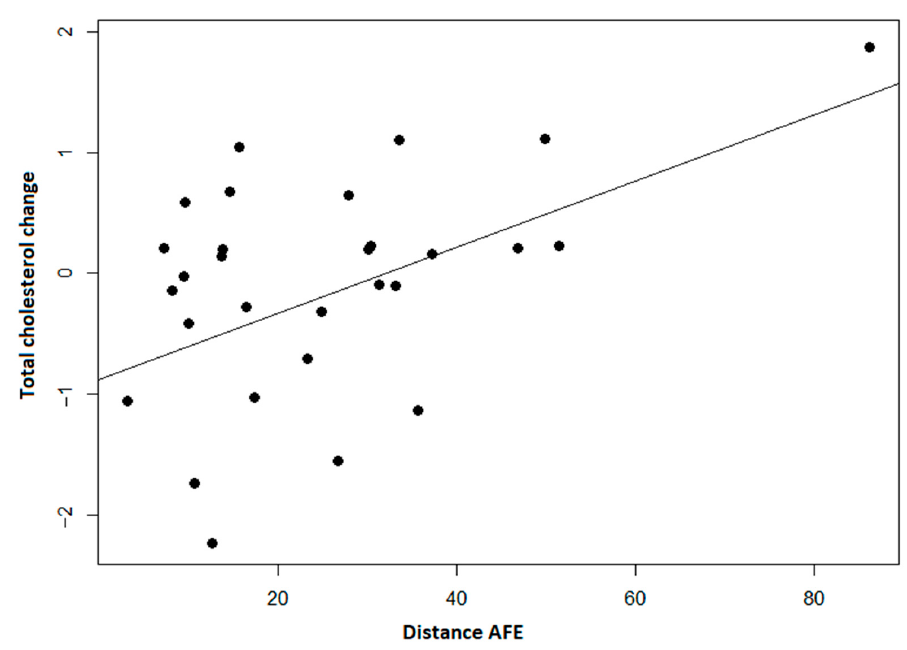
Figure 2. Distance per day area of the fitting ellipse (AFE) and change in total cholesterol shows us that when the fitting ellipse increases, the level of total cholesterol increases ( p < 0.001). The SD1/SD2 ratio showed an opposite relationship with body fat measures indicating that possibly higher short-term variability could be associated with positive changes (Figure 3).